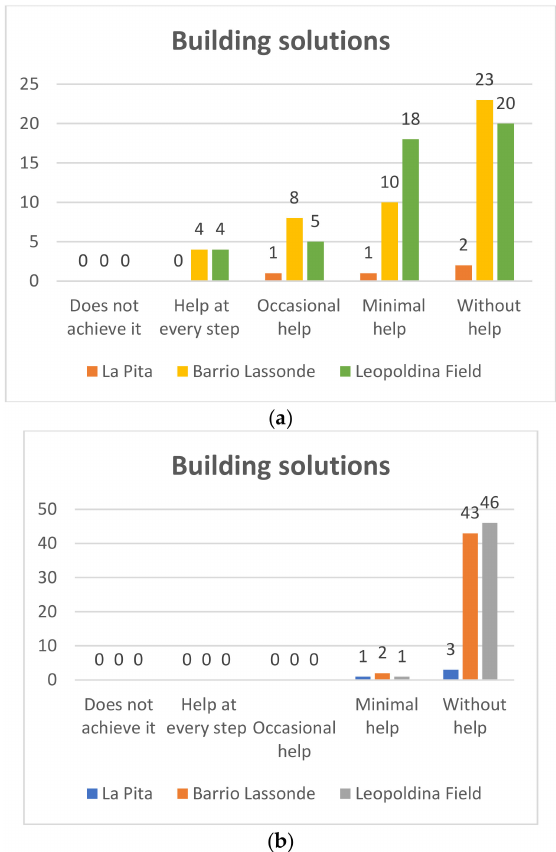
Figure 13. Kindergarden building solutions: Pre-Test ( a ) and Post-Test ( b